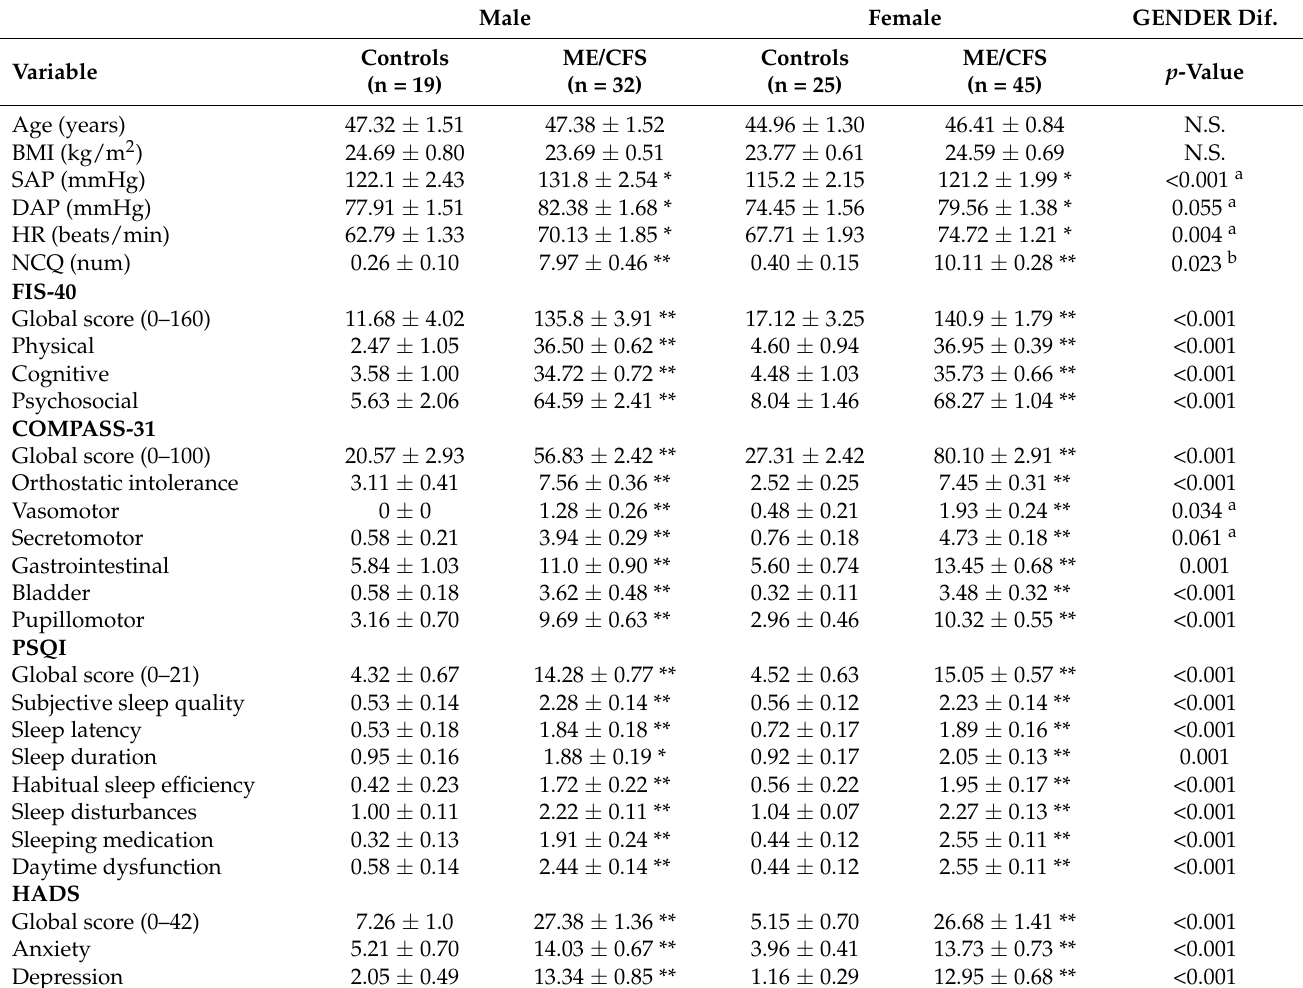
Table 5. Baseline demographic and clinical parameters (mean ± SEM) for men and women by group (data for women from Escorihuela et al., 2020 [14]). Male Female GENDER